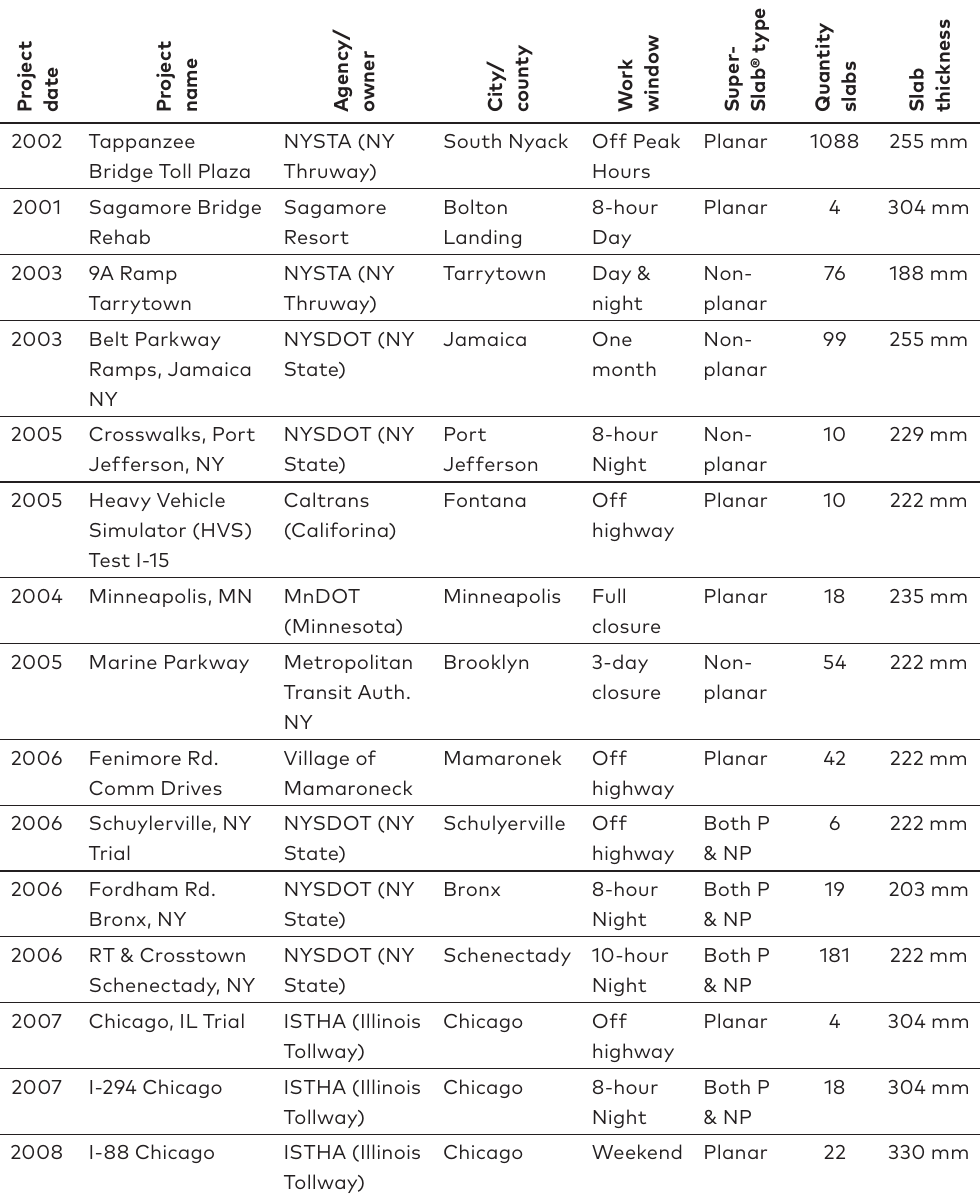
Table 2. Super Slab continuous construction (Fort Miller, n.